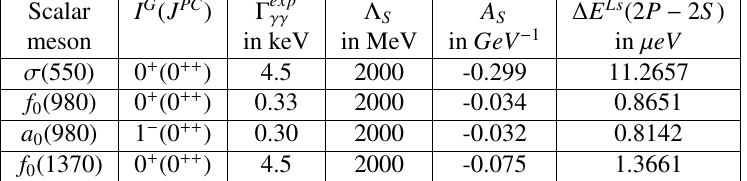
Table 1. Scalar mesons contribution to the energy spectrum of muonic hydrogen